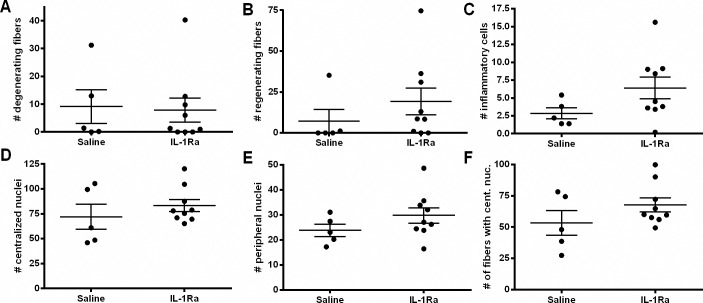
IL-1Ra treatment does not alleviate muscle pathology in mdx mice.Degenerating (A) and regenerating (B) muscle fibers were quantified in gastrocnemius muscle. Inflammatory cells were also quantified in sections from saline- and IL-1Ra-treated mice (C). Nuclei from sections were scored and quantified as either centralized (D) or peripheral (E). The number of fibers with centralized nuclei (F) was quantified by treatment group Values in the graphs represent mean ± SEM. Statistical significance was determined by parametric, unpaired, two-tailed, t-tests (N = 5, saline; N = 9, IL-1Ra).